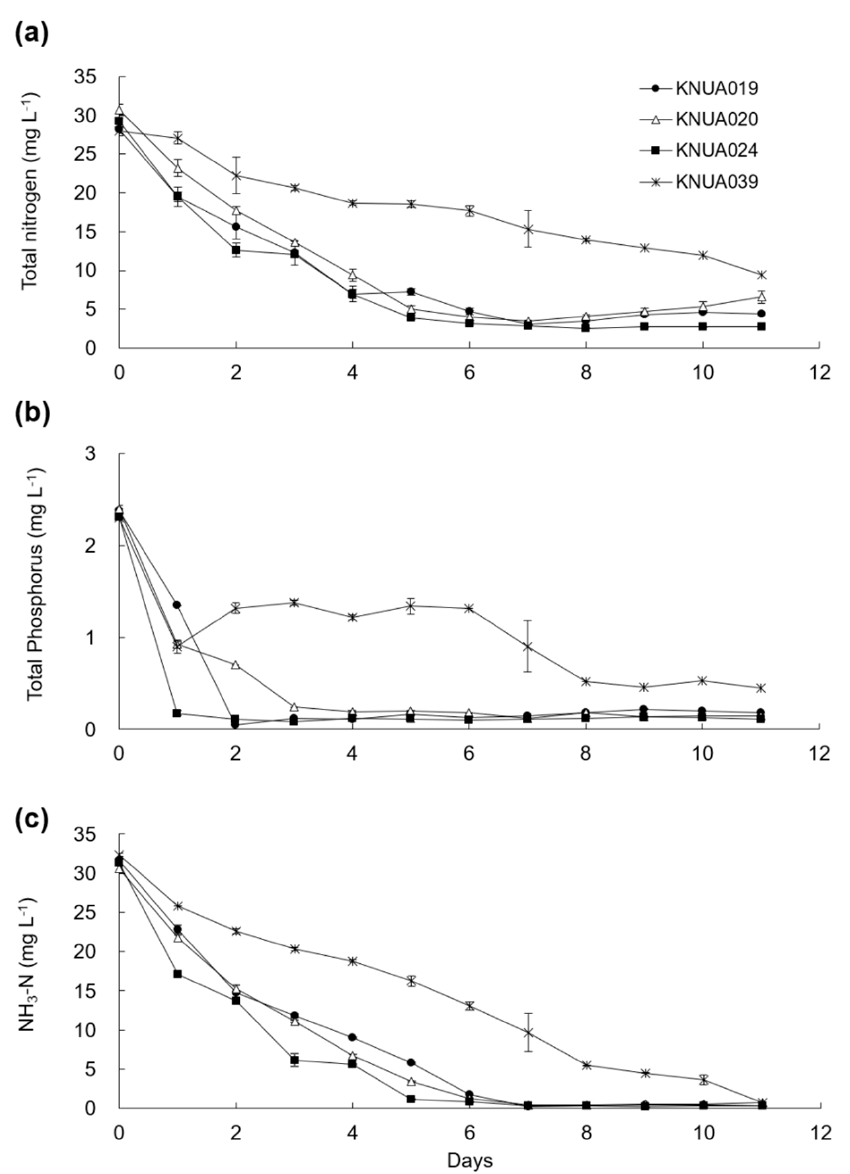
Figure 3. Changes in ( a ) total nitrogen, ( b ) total phosphorus, and ( c ) ammonia concentration for candidate microalgal strains in treated, primary settled